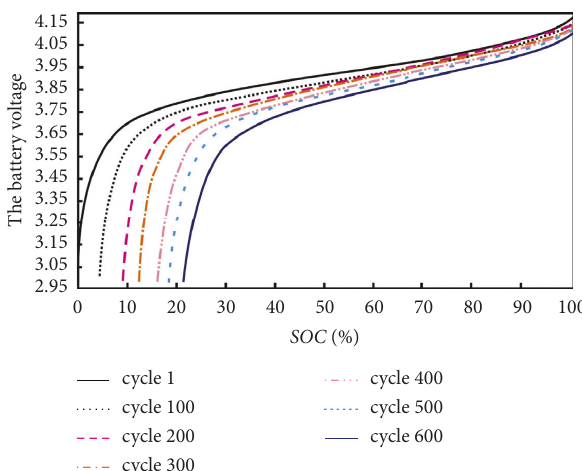
Figure 6: Corresponding curves of battery voltage and SOC under different cycle